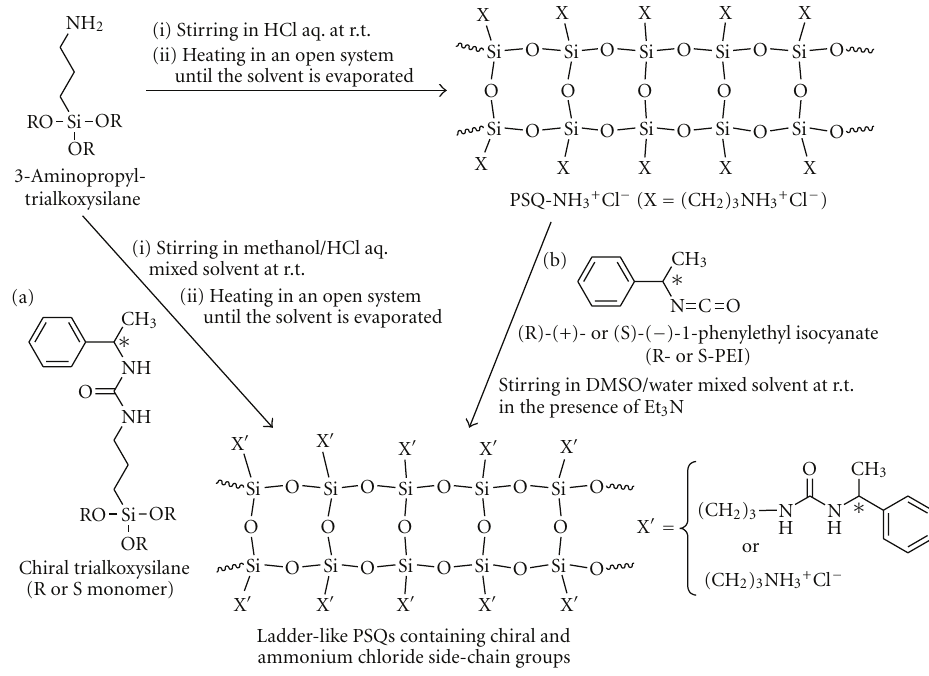
Scheme 3: Preparation of ladder-like PSQs containing chiral and ammonium chloride side-chain groups by (a) copolycondensation method and (b) polymer reaction method.